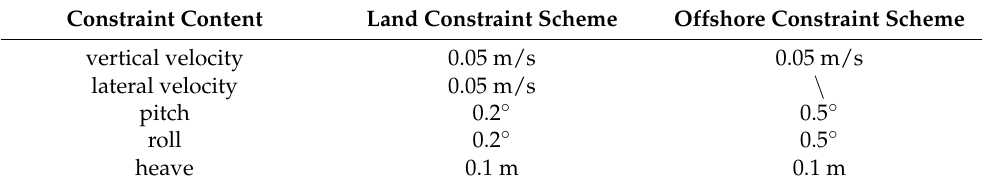
Table 3. Motion constraint